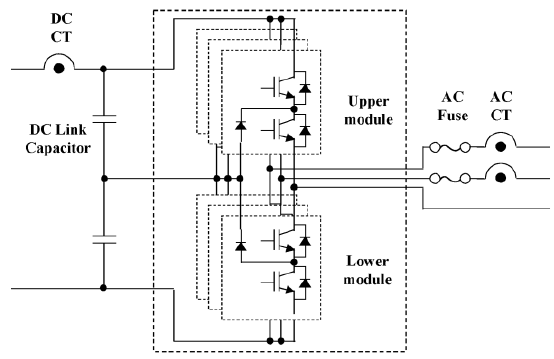
Figure 12. Schematic of one of the arms of the 125 kW power stack. Table 6. Ratings of the major parts for the 125 kW Power stack.